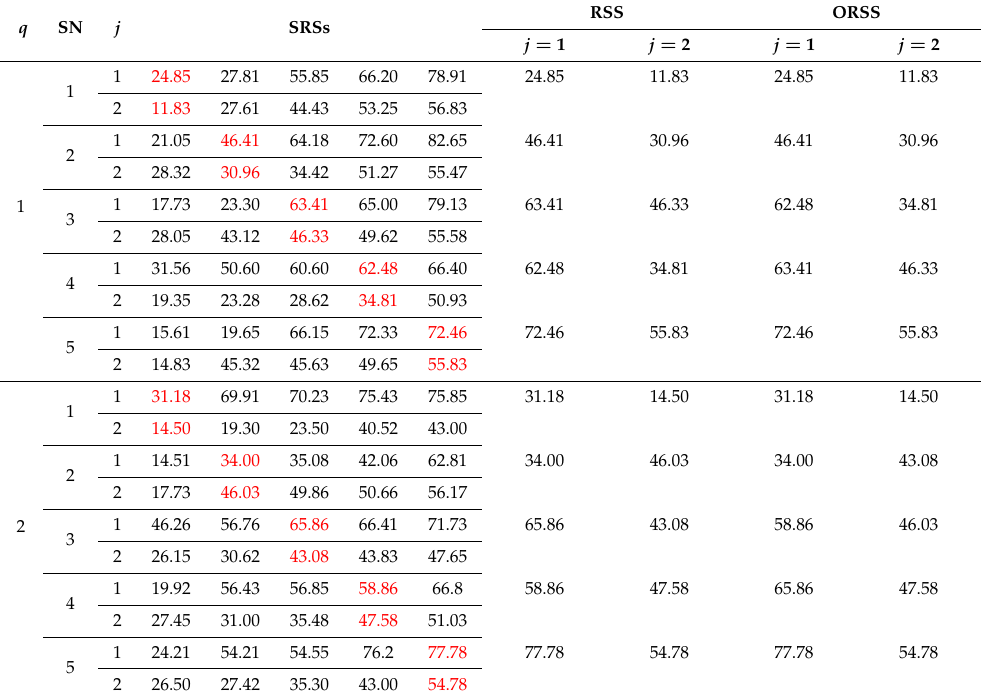
Table 5. The real SRSs and ORSSs (one-cycle and two-cycle).